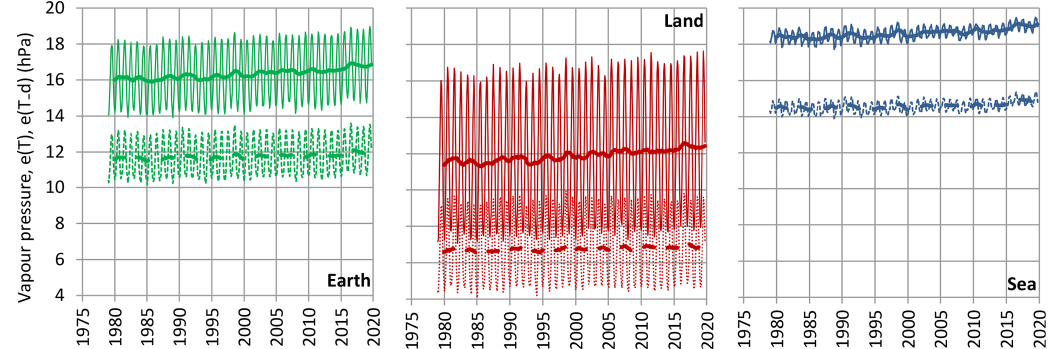
Figure 4. Variation of the saturation water vapour pressure e(T ) (continuous lines) and e(T d ) (dashed lines) for the average temperature T and dew point T d , as shown in Fig. 2. Thin and thick lines of the same colour represent monthly values and running annual averages (right aligned), respectively. Source of the data set is the ERA5 reanalysis, as detailed in Table 1.